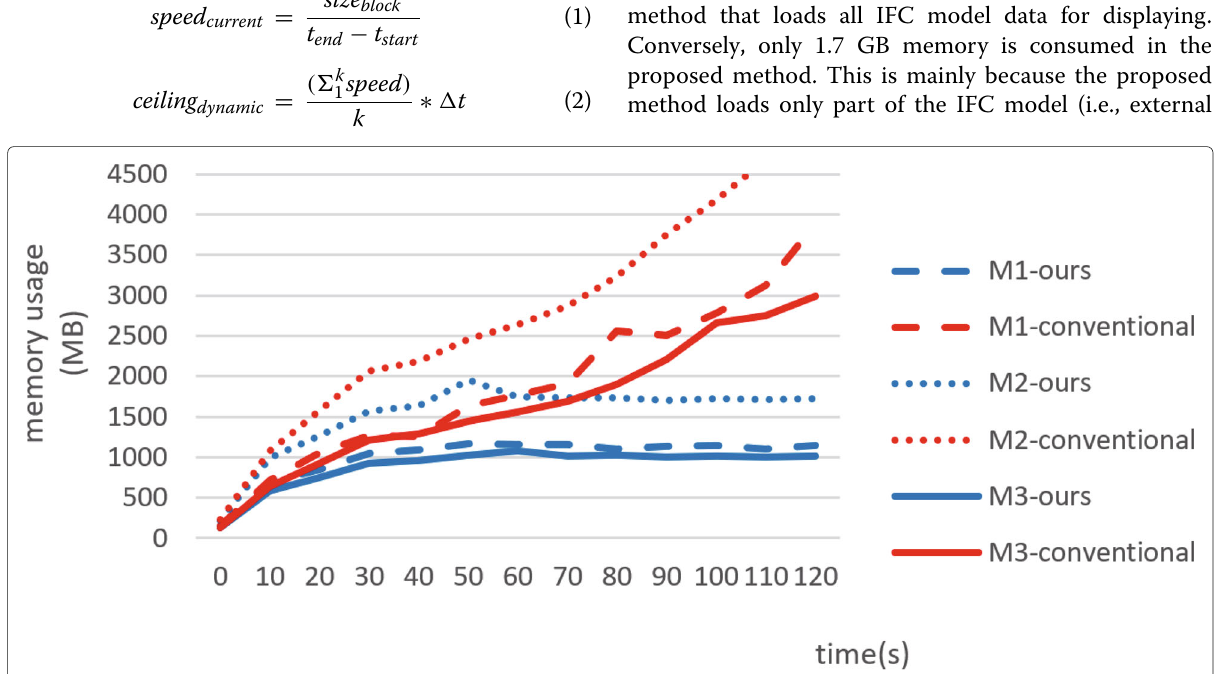
Fig. 8 Memory usage of the test